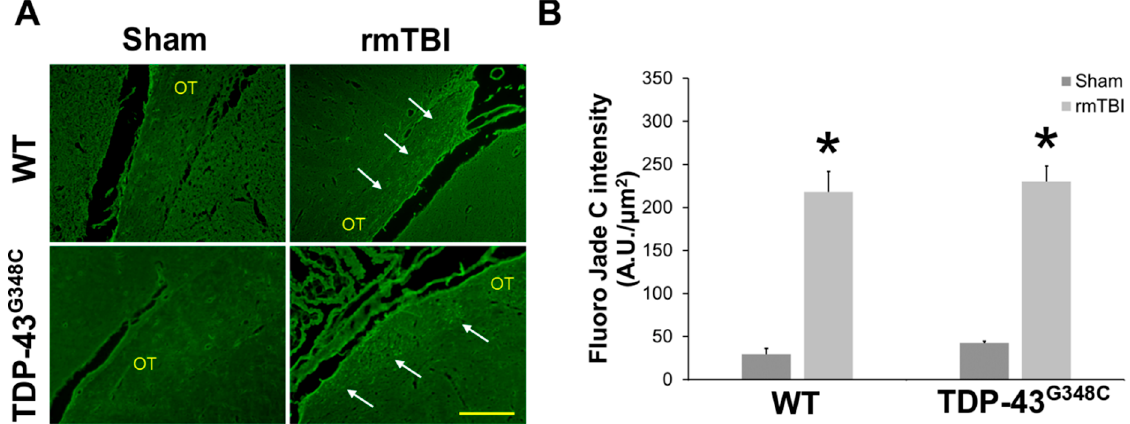
Figure 1. Neurodegeneration in the optic tract (OT) of wild-type (WT) and TDP-43 G348C mice at 6 months after repetitive mild traumatic brain injury (rmTBI). ( A ) Representative microphotographs of the OT stained with the Fluoro ‐ Jade C fluorescent dye. Arrows point to Fluoro ‐ Jade C ‐ positive staining. Scale bar: 100 μ m. ( B ) The histogram shows the intensity levels of the fluorescent staining (AU/ μ m 2 ) in the OT of WT and TDP ‐ 43 G348C mice of the control groups (Sham) and animals with rmTBI. Results are expressed as means ± SEM ( N = 5). * p < 0.05, significantly different from the related Sham.